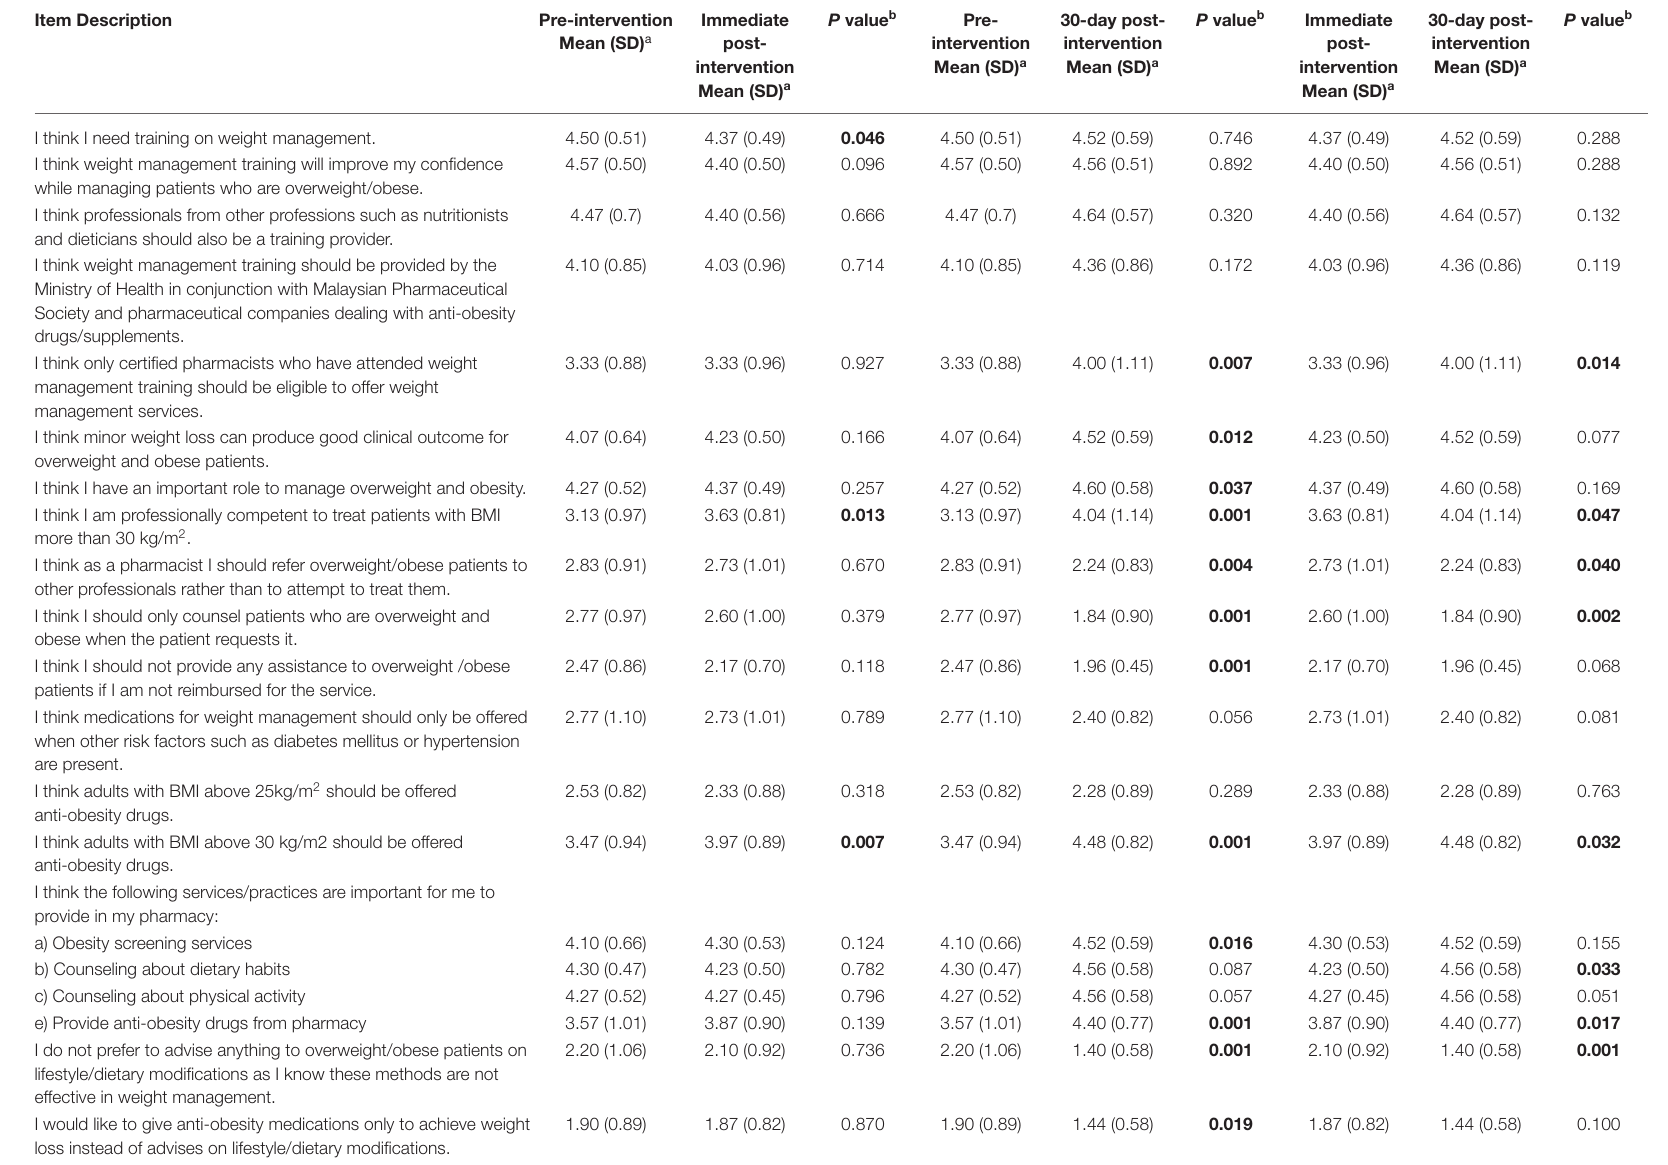
TABLE 3 | The impact of the intervention on attitude of participants towards weight management training and weight management services. Item Description Pre-intervention